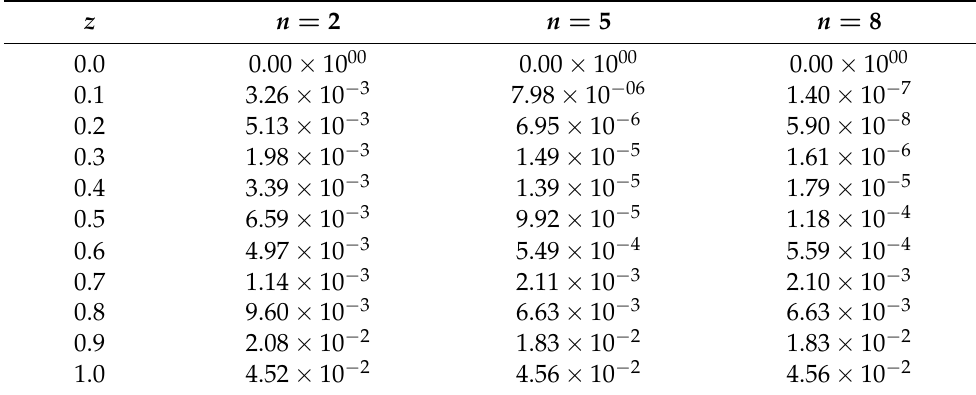
Table 9. Absolute error for n = 2, 5 and 8 in Example